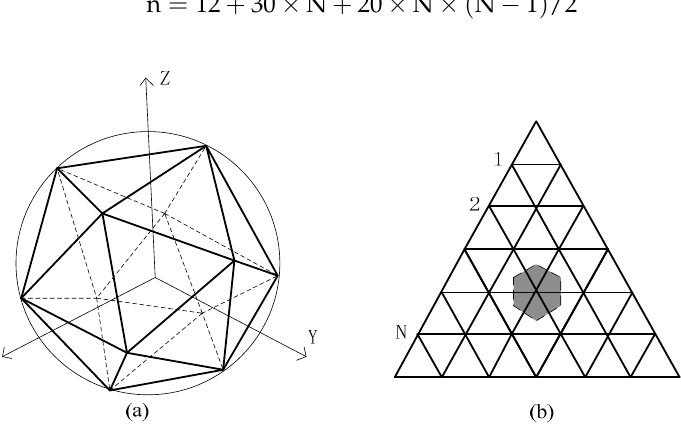
Figure 4. Star catalog partition model. ( a ) The celestial sphere is divided into twenty equivalent zones by an inscribed icosahedron. ( b ) Each of twenty regions is divided into several congruent equilateral triangles.